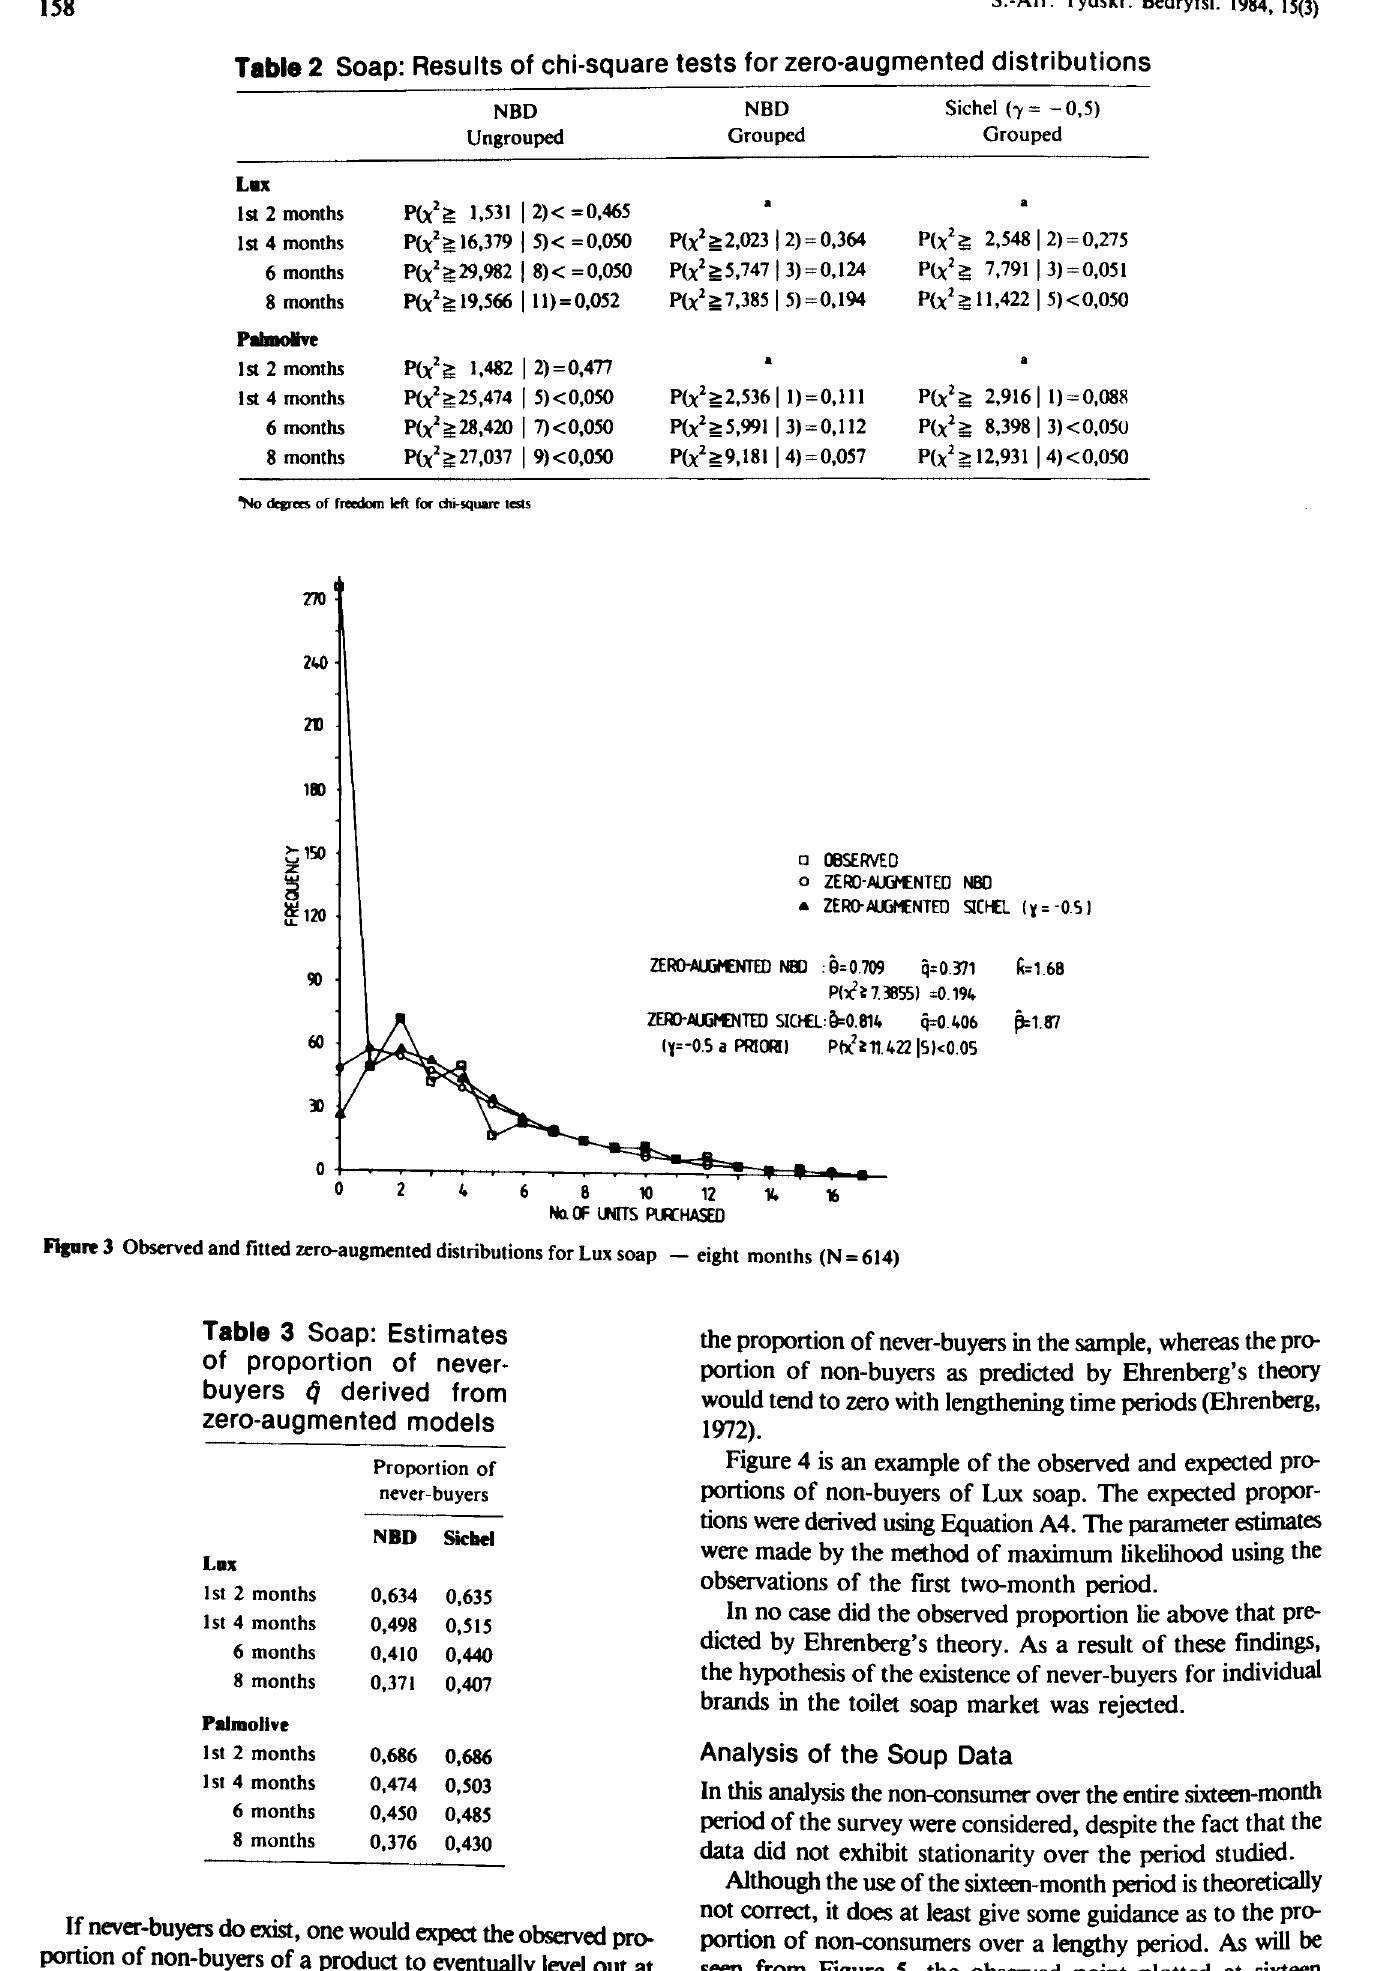
Table 2 Soap: Results of chi-square tests for zero-augmented distributions